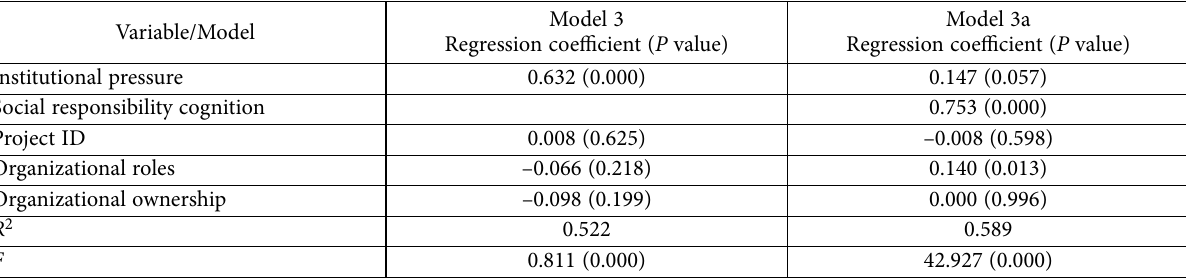
Table 7. Regression results for Model 3